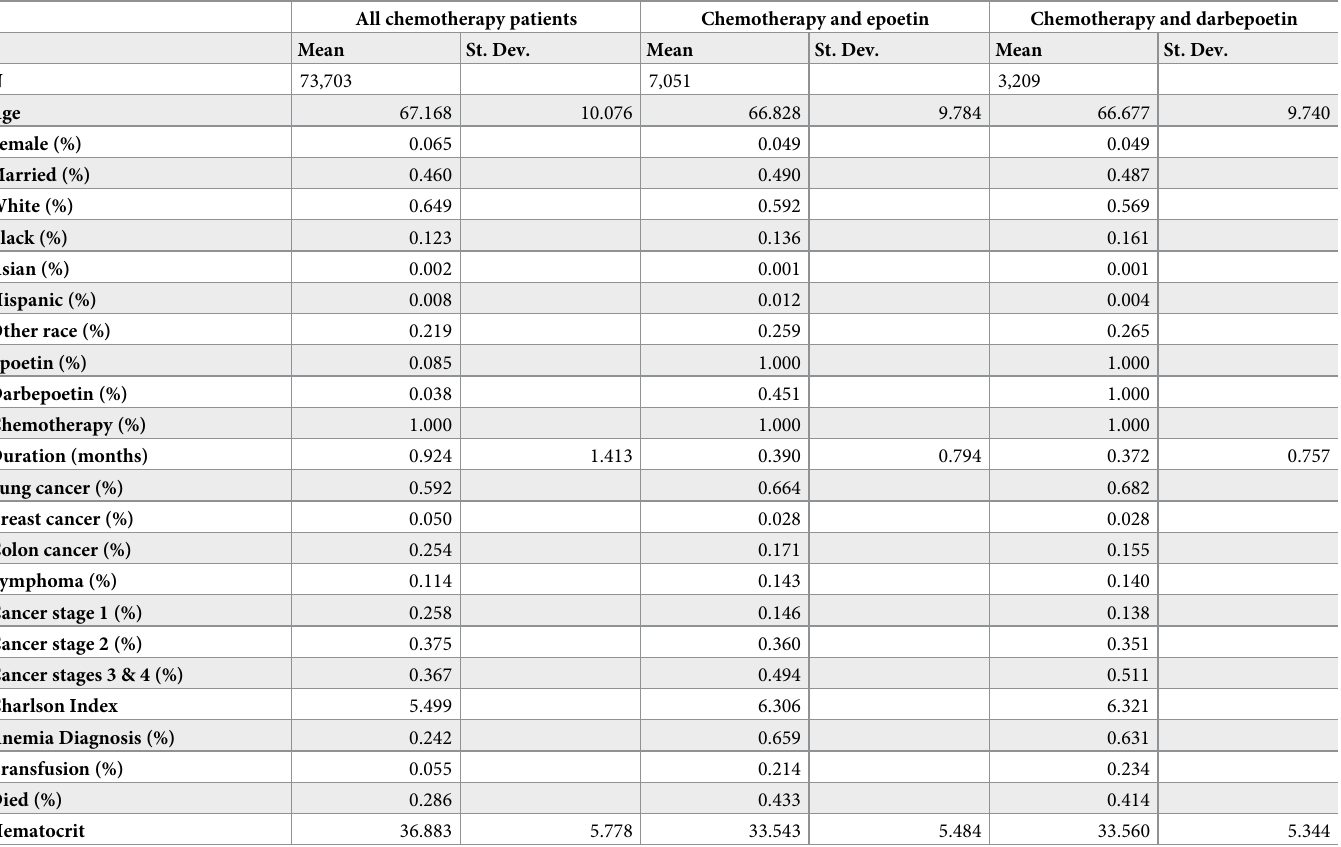
Table 2. Summary statistics.